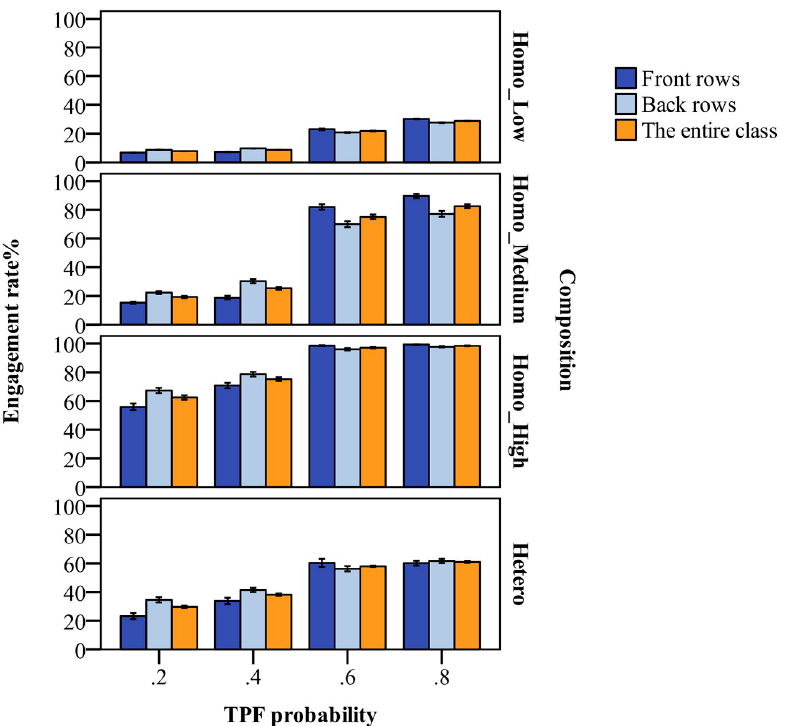
Fig 4. Simulated classroom engagement of front and back rows and the entire class under teacher feedback effects and near-seated peer group influence. The meanings of TPF, Composition, Homo_Low, Homo_Medium, Homo_High and Hetero are the same to those in Fig 3. The classroom engagement rates of front vs. back rows and the entire class are jointly impacted by the teacher’s positive feedback probability and classroom engagement